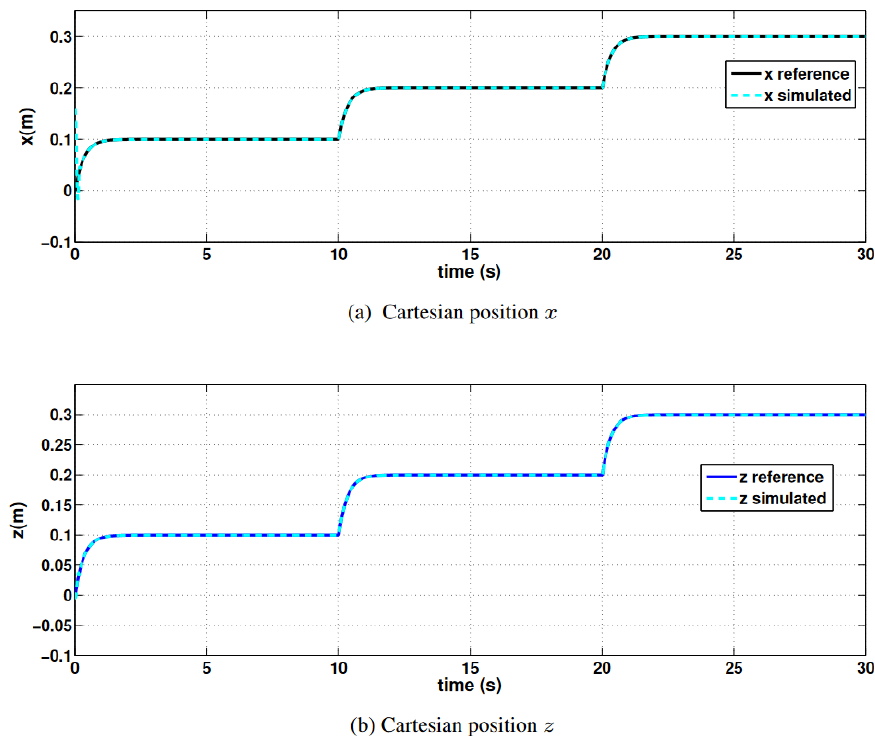
Figure 2. Cartesian sliding-mode control.